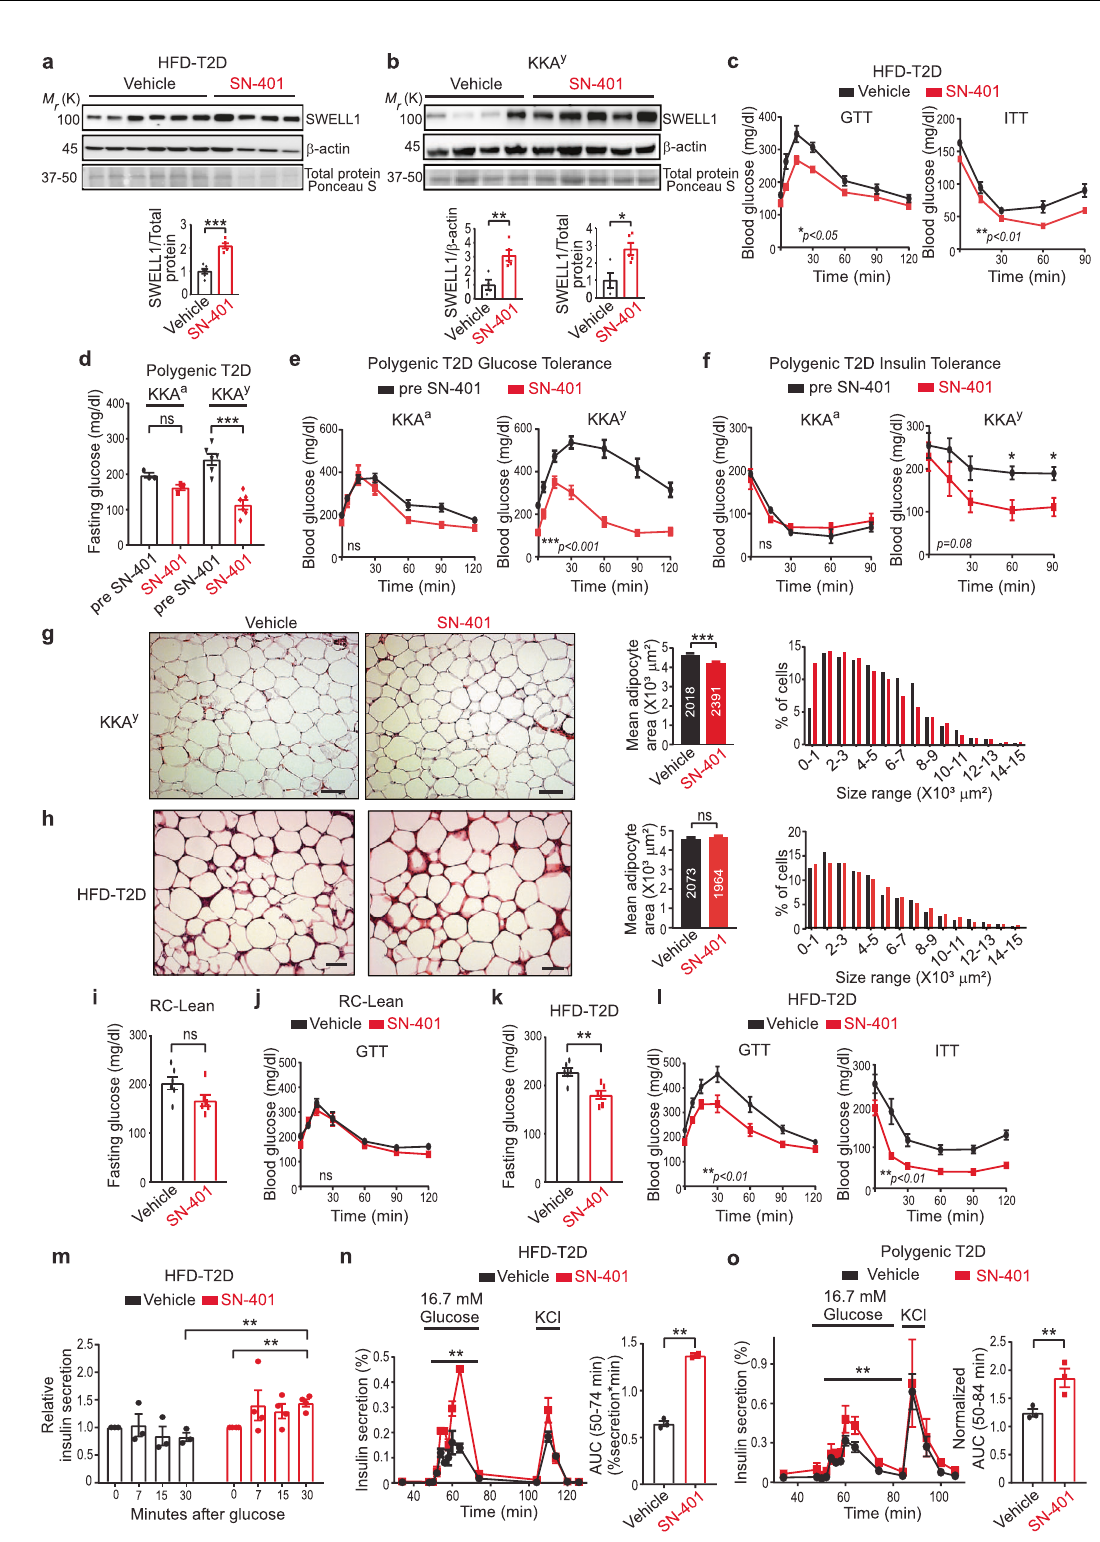
increased 2.8-fold by SN-401 (Fig. 4k). Taken together, these data reveal that SN-401 augments SWELL1 protein and SWELL1-mediated signaling in some tissues, while also increas- ing serum FGF21 to concomitantly enhance both systemic insulin sensitivity and pancreatic β -cell insulin secretion, thereby normalizing glycemic control in T2D mouse models. This improved metabolic state can reduce ectopic lipid